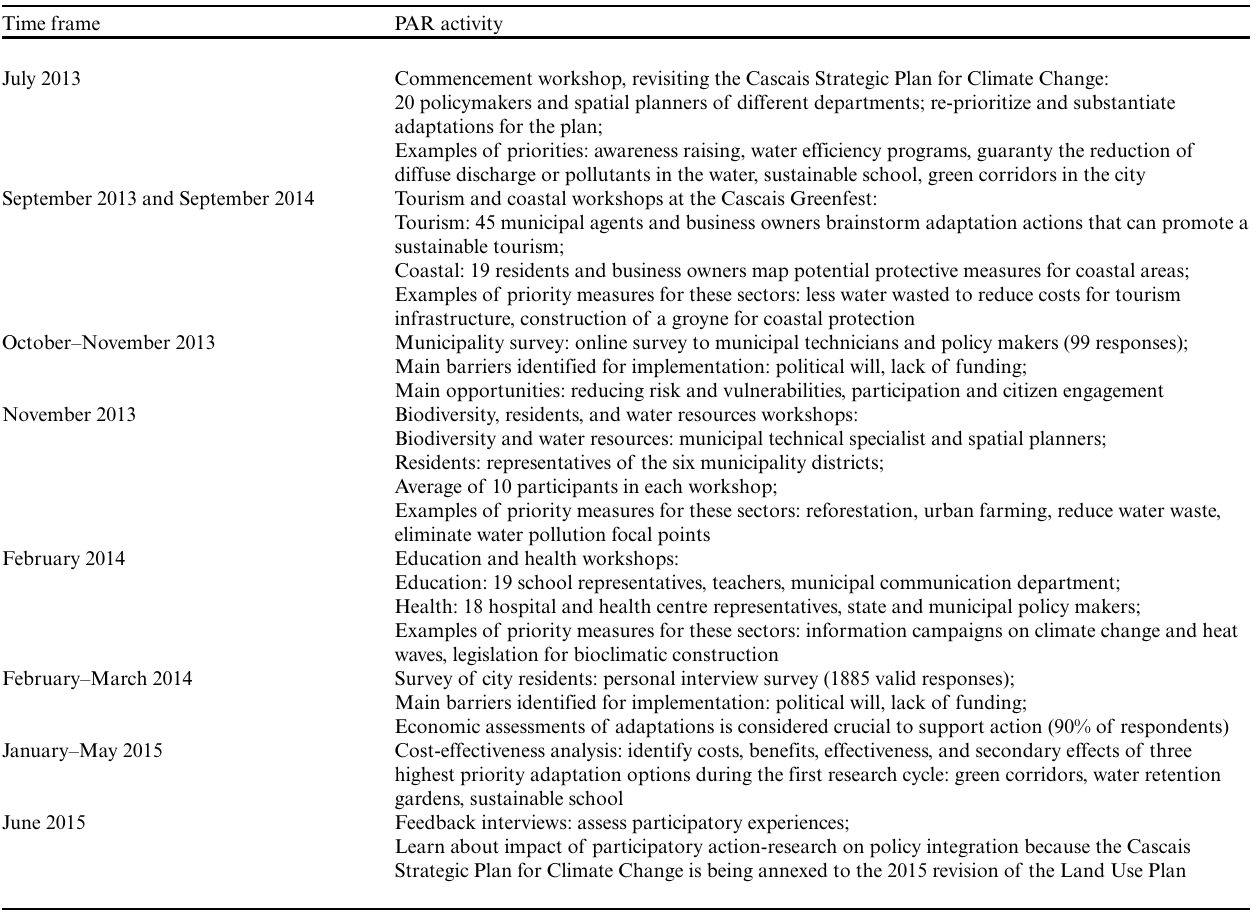
Table 3. Synthesis of participatory action-research in Cascais Municipality (Case